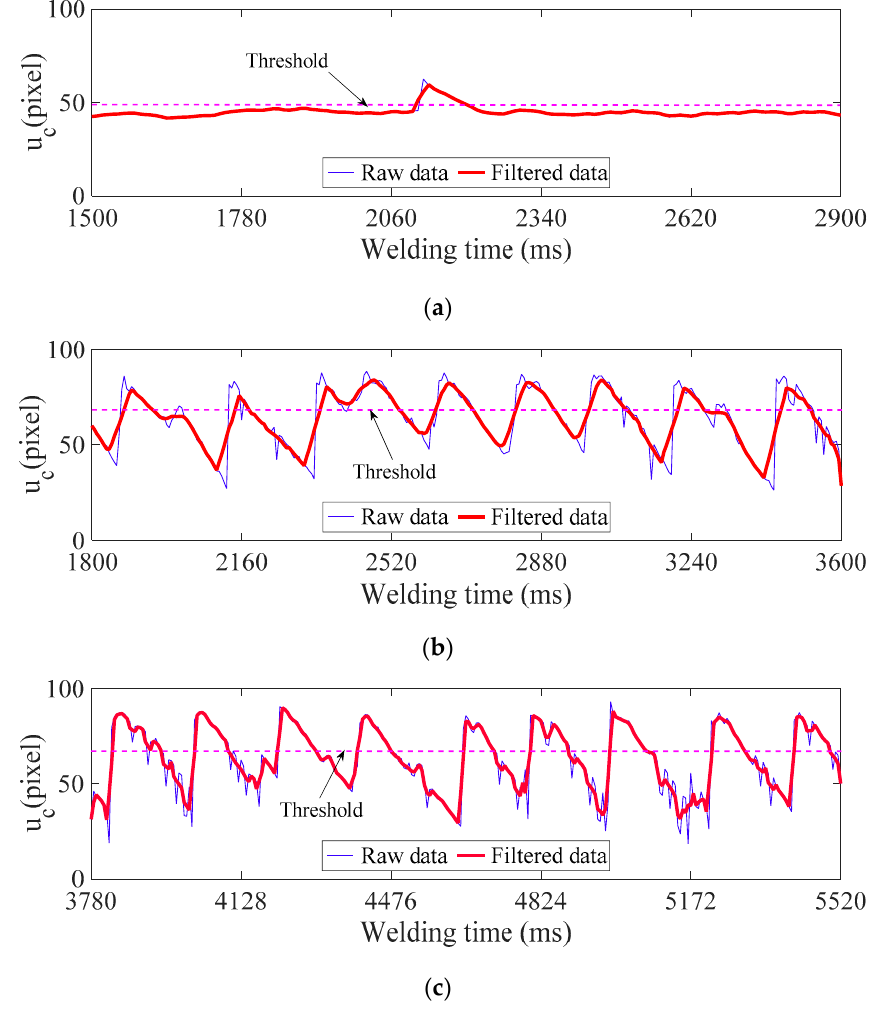
Figure 12. Detection results using standard deviation (STD) threshold in monitoring parameters u c : ( a ) u c in Figure 8; ( b ) u c in Figure 9; and, ( c ) u c in Figure 10.